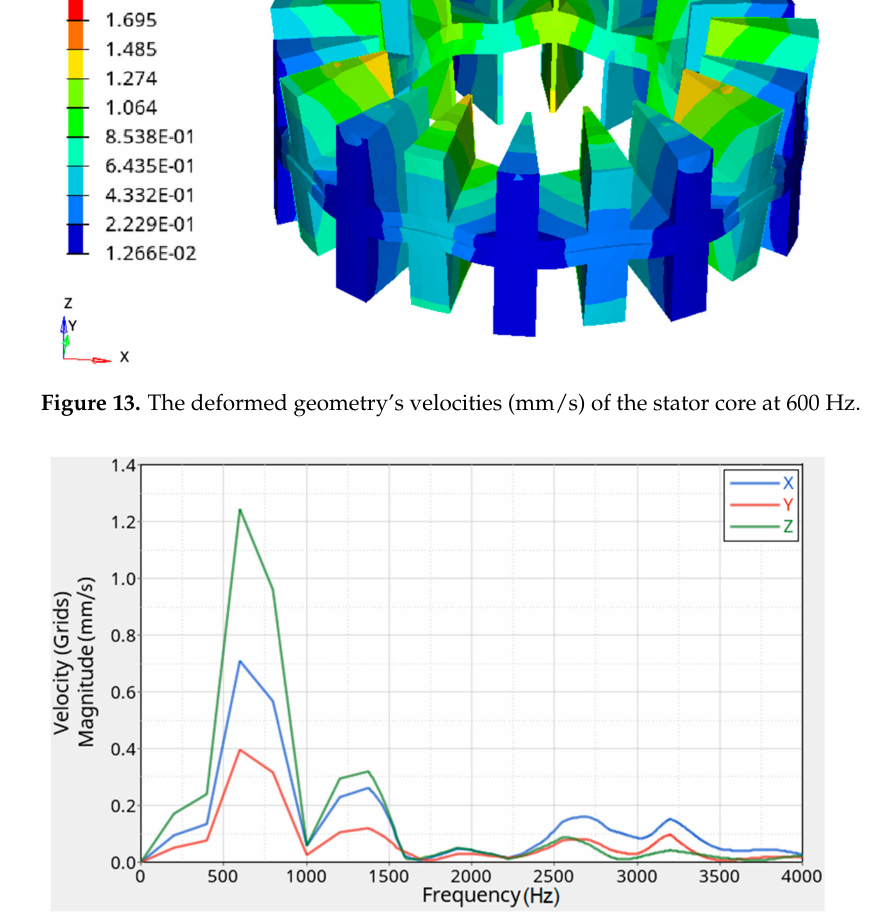
Figure 14. The velocity values of the stator teeth in the range of the analyzed